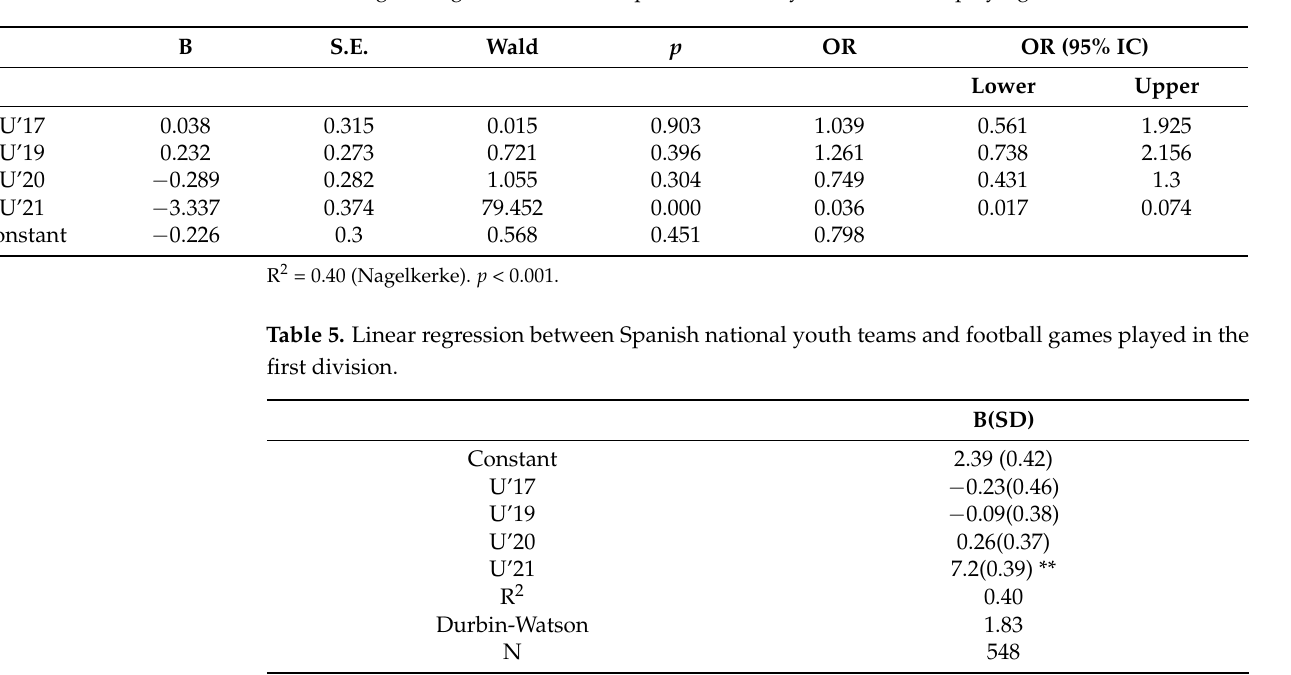
Table 4. Logistic regression between Spanish national youth teams and playing in first division soccer. B